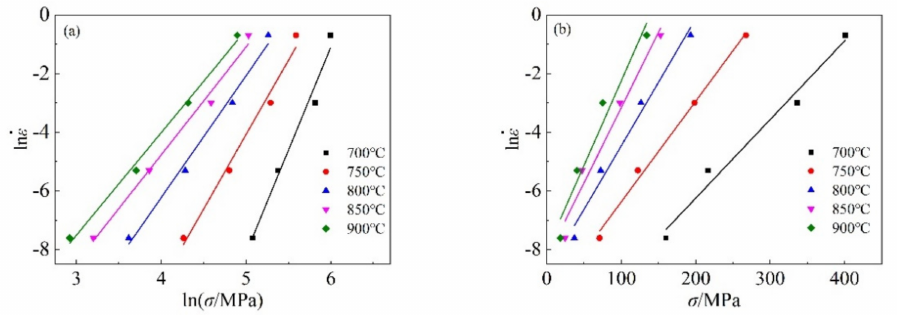
Figure 6. Relation diagram of strain rate and flow stress of Ti-6Mo-5V-3Al-2Fe alloy under strain . ε . ε 0.7 ln - σ curve ( a ) and ln -ln σ curve ( b